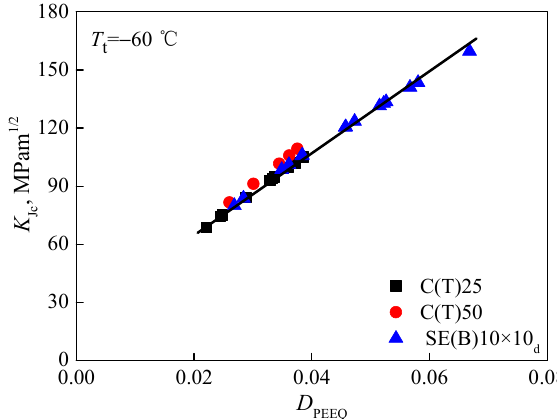
Figure 7. Relation between fracture toughness K Jc and constraint parameter D PEEQ .